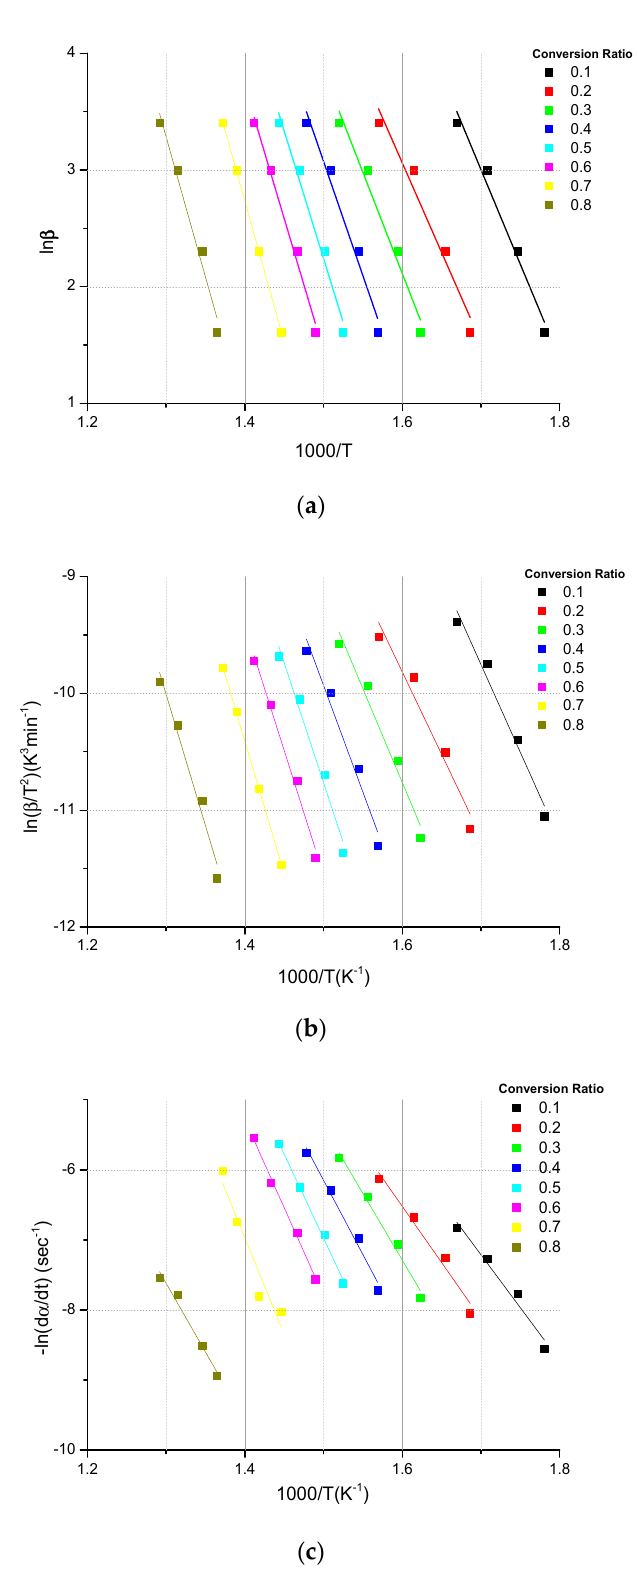
Figure 3. Plots for kinetic models for Mixed ASR. ( a ) Flynn-Wall-Ozawa (FWO), ( b ) Kissinger-Akahira-Sunose (KAS), ( c ) Friedman. Table 2. Calculated kinetic parameter, r 2 values and E ( kJ/mol ) of the fitted equation from FWO, KAS and Friedman models.